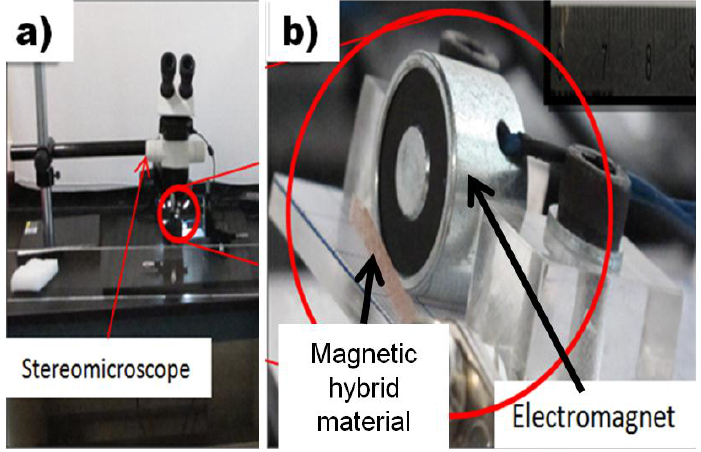
Figure 8. Experimental setup for the magnetic experimentations. ( a ) General view